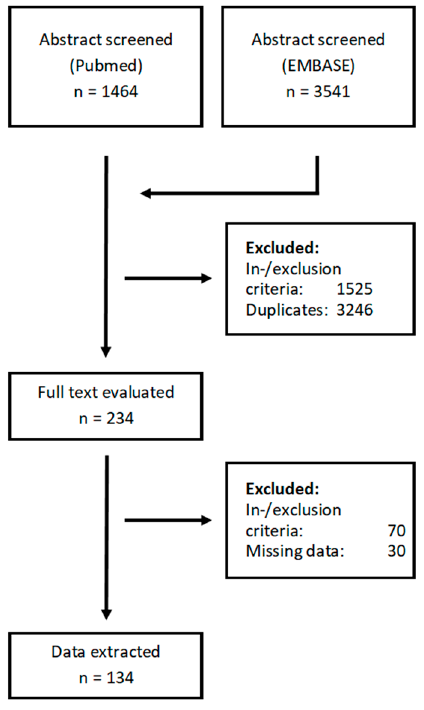
Figure 1. Screening process.